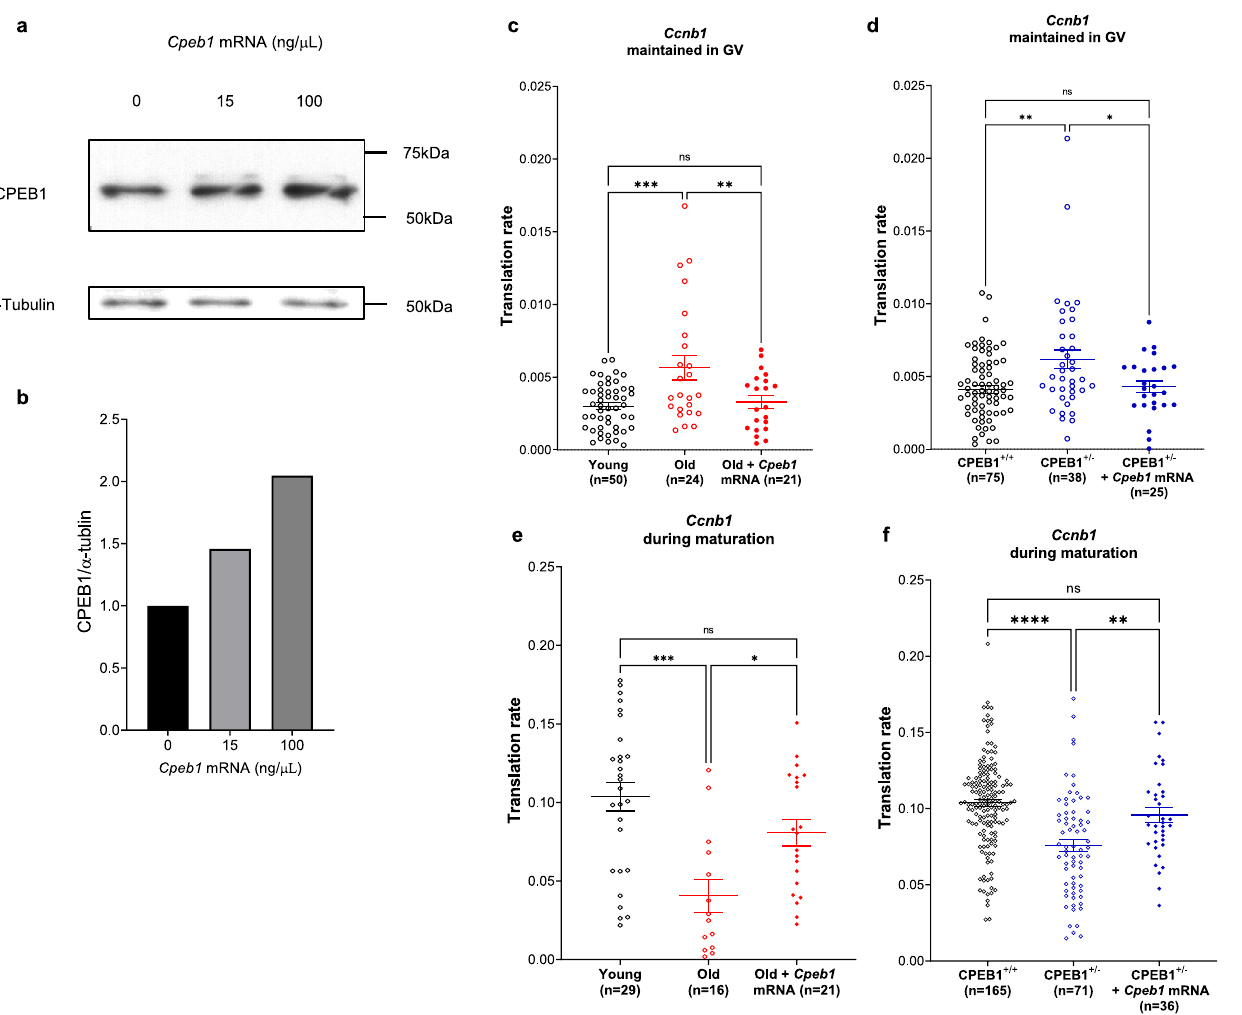
Fig. 7 | CPEB1 decreasedfunctioninold oocytes canbe rescuedby injectionof Cpeb1 mRNA. a , b CPEB1 protein expression in GV oocytes injected with Cpeb1 mRNAatdifferentconcentrations.Accumulationoftheendogenous α -tubulinwas used asacontrol. Oocytes werelysed in asamplebufferand used forwesternblot analysis. In total, 30 oocytes per lane were loaded for the experiment. b A graph shows quanti fi cation of a single western blot analysis. CPEB1/ α -tubulin ratios were expressed as fold changes over control. c – f GV oocytes from young and old mice, or Cpeb1 +/+ ;Zp3Cre mice (CPEB1 +/+ oocytes) and Cpeb1 fl /+ ;Zp3Cre mice (CPEB1 +/ − oocytes)wereinjectedwithpolyadenylatedmCherry, YFP-Ccnb1 3 ’ -UTR,and Cpeb1 mRNA (100ng/ μ l). After overnight pre-incubation, oocytesweremaintained inGV